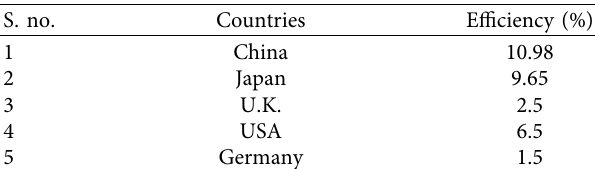
Table 1: Comparison of semiconductor materials in worldwide countries’ efficiency.